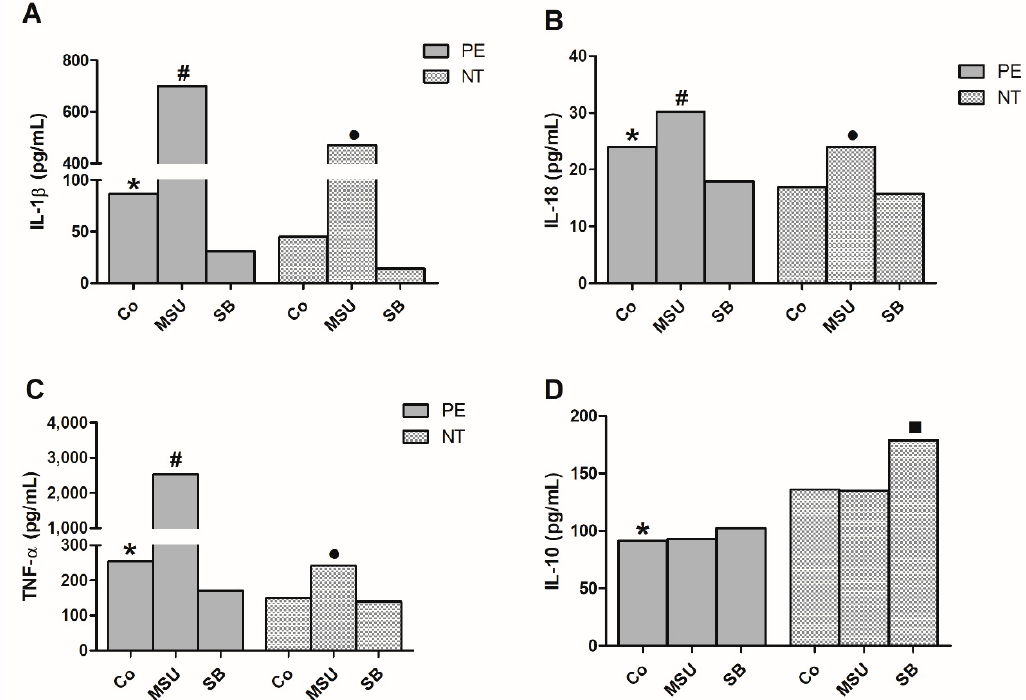
Figure 3 . IL-1 β ( A ), IL-18 ( B ), TNF- α ( C ) and IL-10 ( D ) production by monocytes. Monocytes from pregnant women with preeclampsia (PE) and NT pregnant women were cultured in the absence (Co) or presence of MSU or SB. Results are shown as the median. * p < 0.05 vs. NT Co, PE SB; # p < 0.05